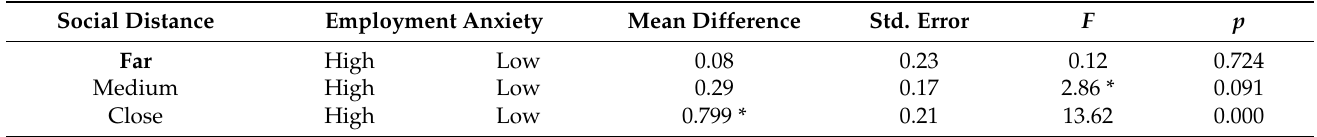
Table 2. Simple effect